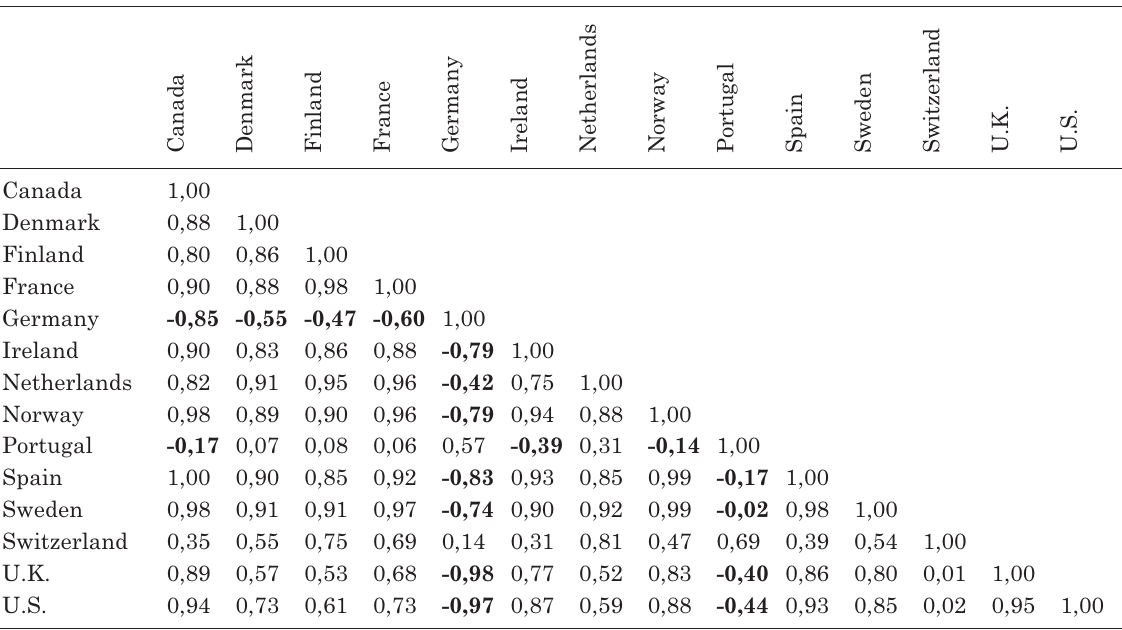
Table 4. Correlation matrix for international property returns (hedged